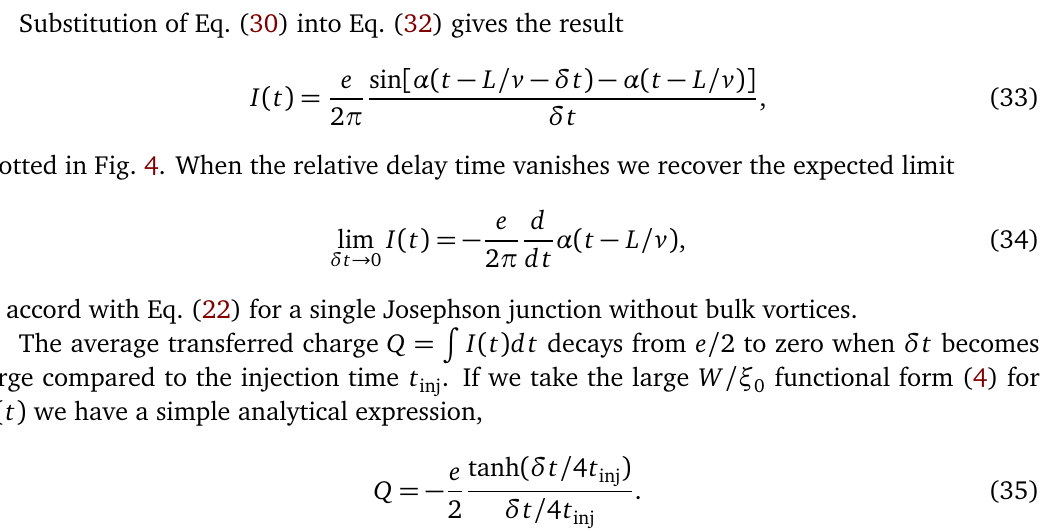
Figure 4: Time dependent current I ( t ) (in dimensionless units) produced by the fusion of two edge vortices in the geometry of Fig. 3. The phase φ ( t ) across the single Josephson junction increases linearly from 0 at t = 0 to 2 π at t = 1. The amplitude α ( t ) is calculated from Eq. (3) at W /ξ = 5, so that t = ( 10 π ) − 1 ≈ 0.03. The three 0 inj curves, calculated from Eq. (33), correspond to different values of the relative delay δ t between edge vortices on upper and lower edge. The current pulse is suppressed when δ t (cid:29) t inj